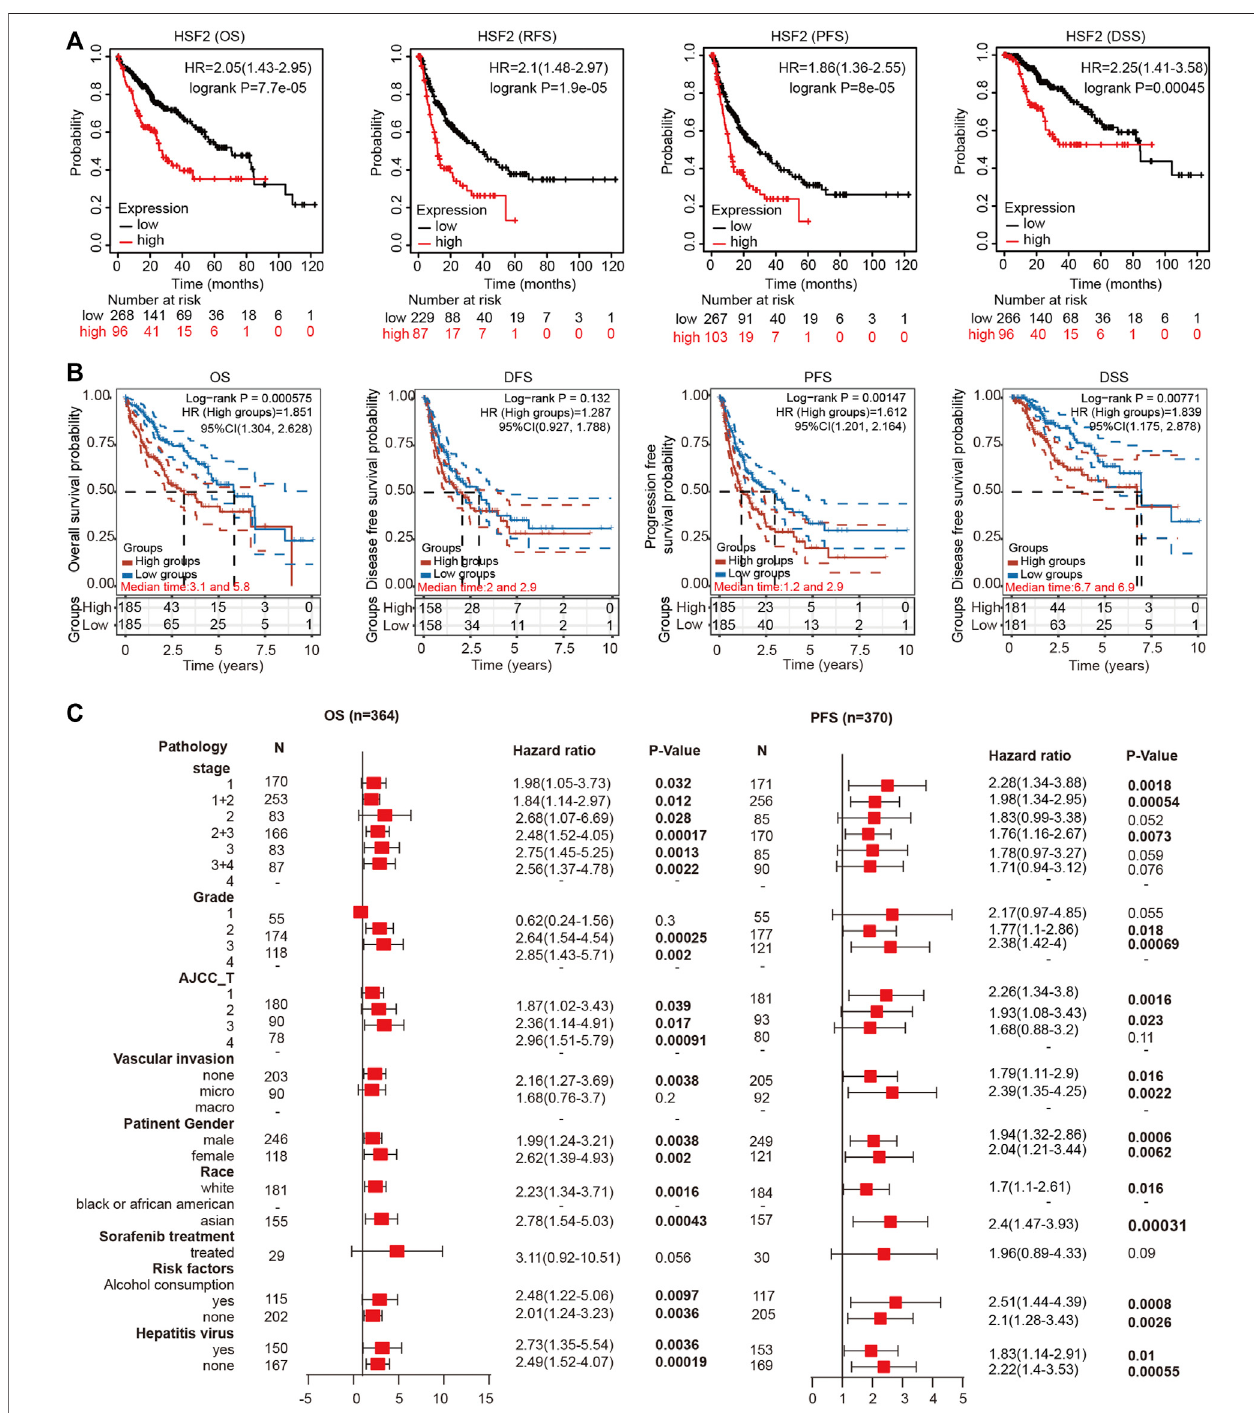
FIGURE3 | High HSF2 expression was correlated with apoor survival ratein patients with HCC. (A) OS, RFS, PFS and DSSof HCC cohorts, asdetermined using Kaplan-Meierplotteranalysis. (B) OS,PFS,DFSandDSSofHCCcohortsinTCGAdatabaseareshownusingtheRsoftwarepackagesurvivalandsurvminer. (C) Forest plots showing the association between HSF2 expression and clinicopathological parameters of patients with HCC.